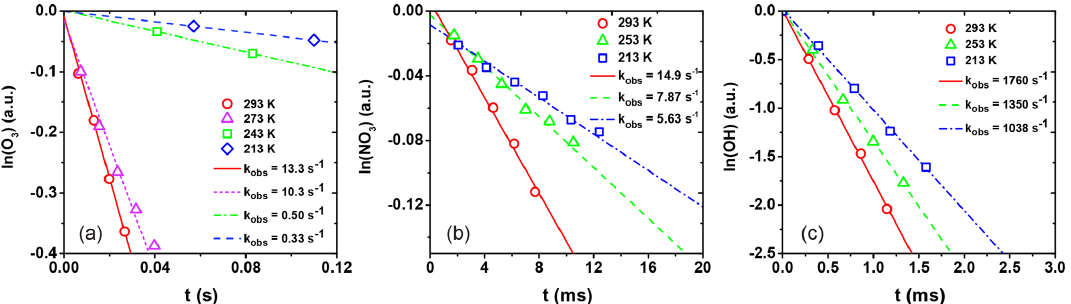
Figure 6. Natural logarithm of the change in gas-phase oxidant signal as a function of reaction time for (a) O 3 uptake by CA, (b) NO 3 uptake by the LEV/XYL mixture, and (c) OH uptake by the GLU/HEX mixture. Open circles, triangles, squares, and diamonds correspond to uptake measurements at different temperatures. Lines represent the corresponding linear fits to the data and corresponding slopes. k obs values are given in the